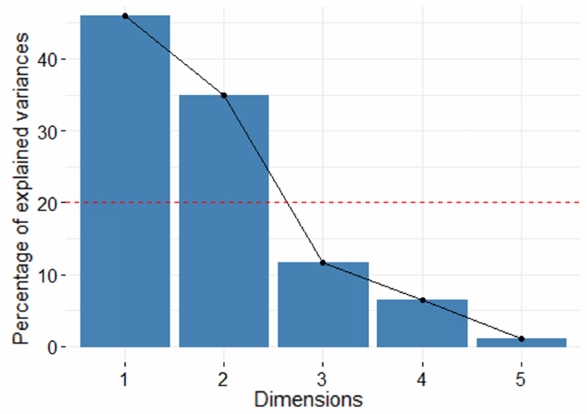
Figure 6: Percentage of the explained variance by each dimension. The red dashed line represents the n average eigenvalue above which the axis should be taken into account in the interpretation of the